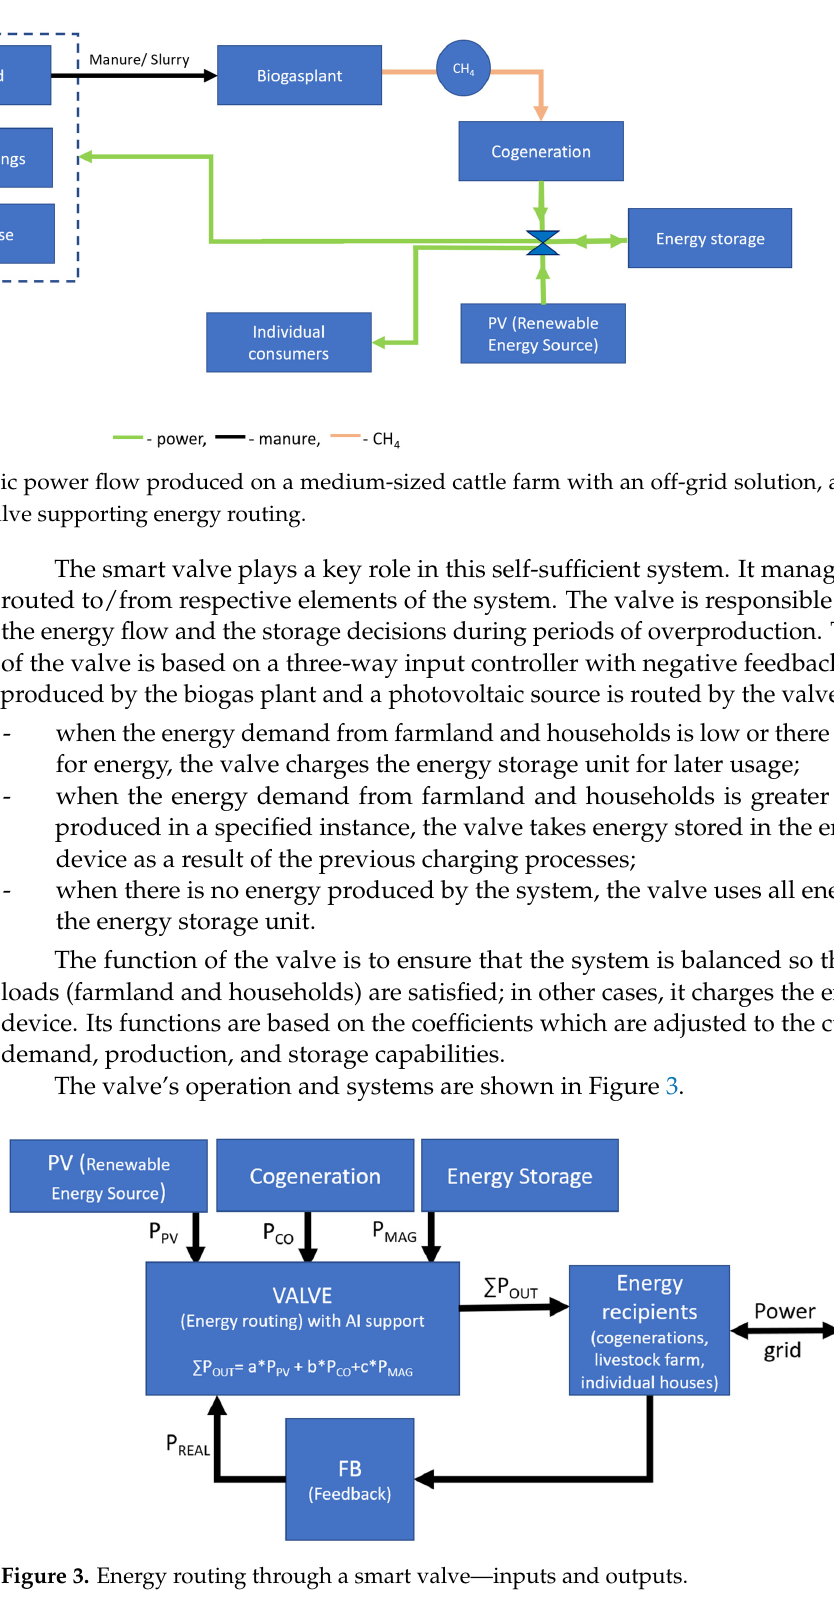
Figure 1. Diagram of energy flow (heat, electric power, manure, and CH 4 )—produced on a medium-sized cattle farm with an on-grid connection.